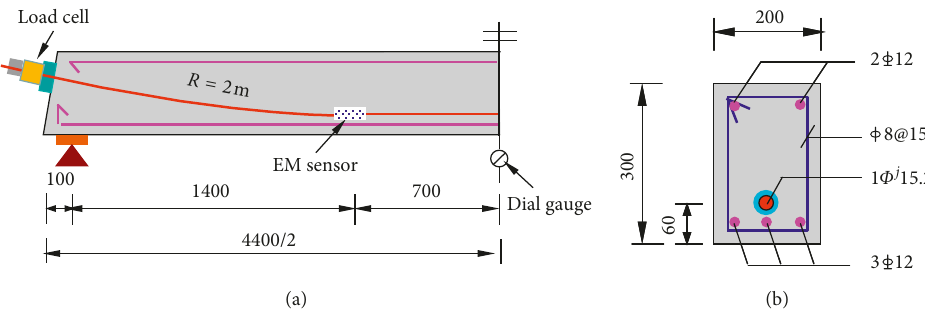
Figure 7: Structural dimensions and sensor layout of beams PC1 and PC4. (a) Profile. (b) Cross section (at